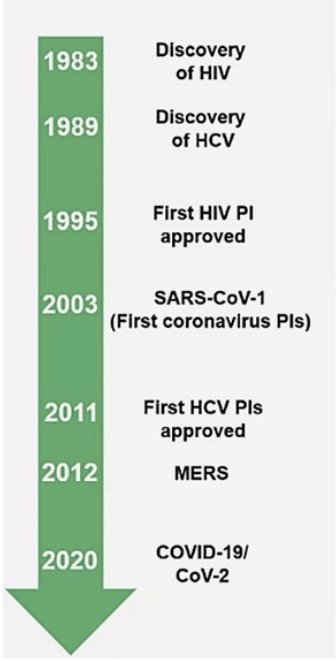
Figure 1. Protease inhibitors (PIs) evolution.